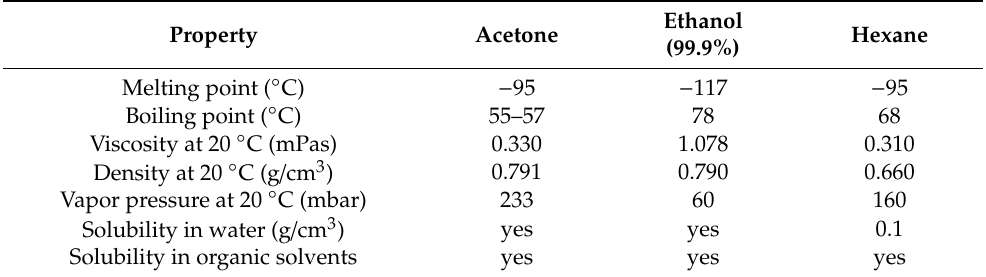
Table 1. Physical properties of solvents employed in